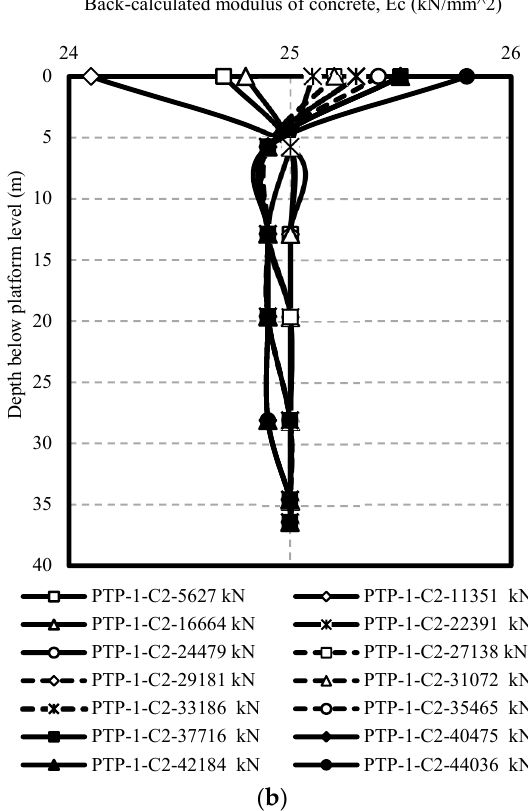
Figure 15. Distribution of back-calculated elastic modulus of concrete, E c (kN/mm 2 ) for BP# 1; ( a ) 1st cycle and ( b ) 2nd cycle.